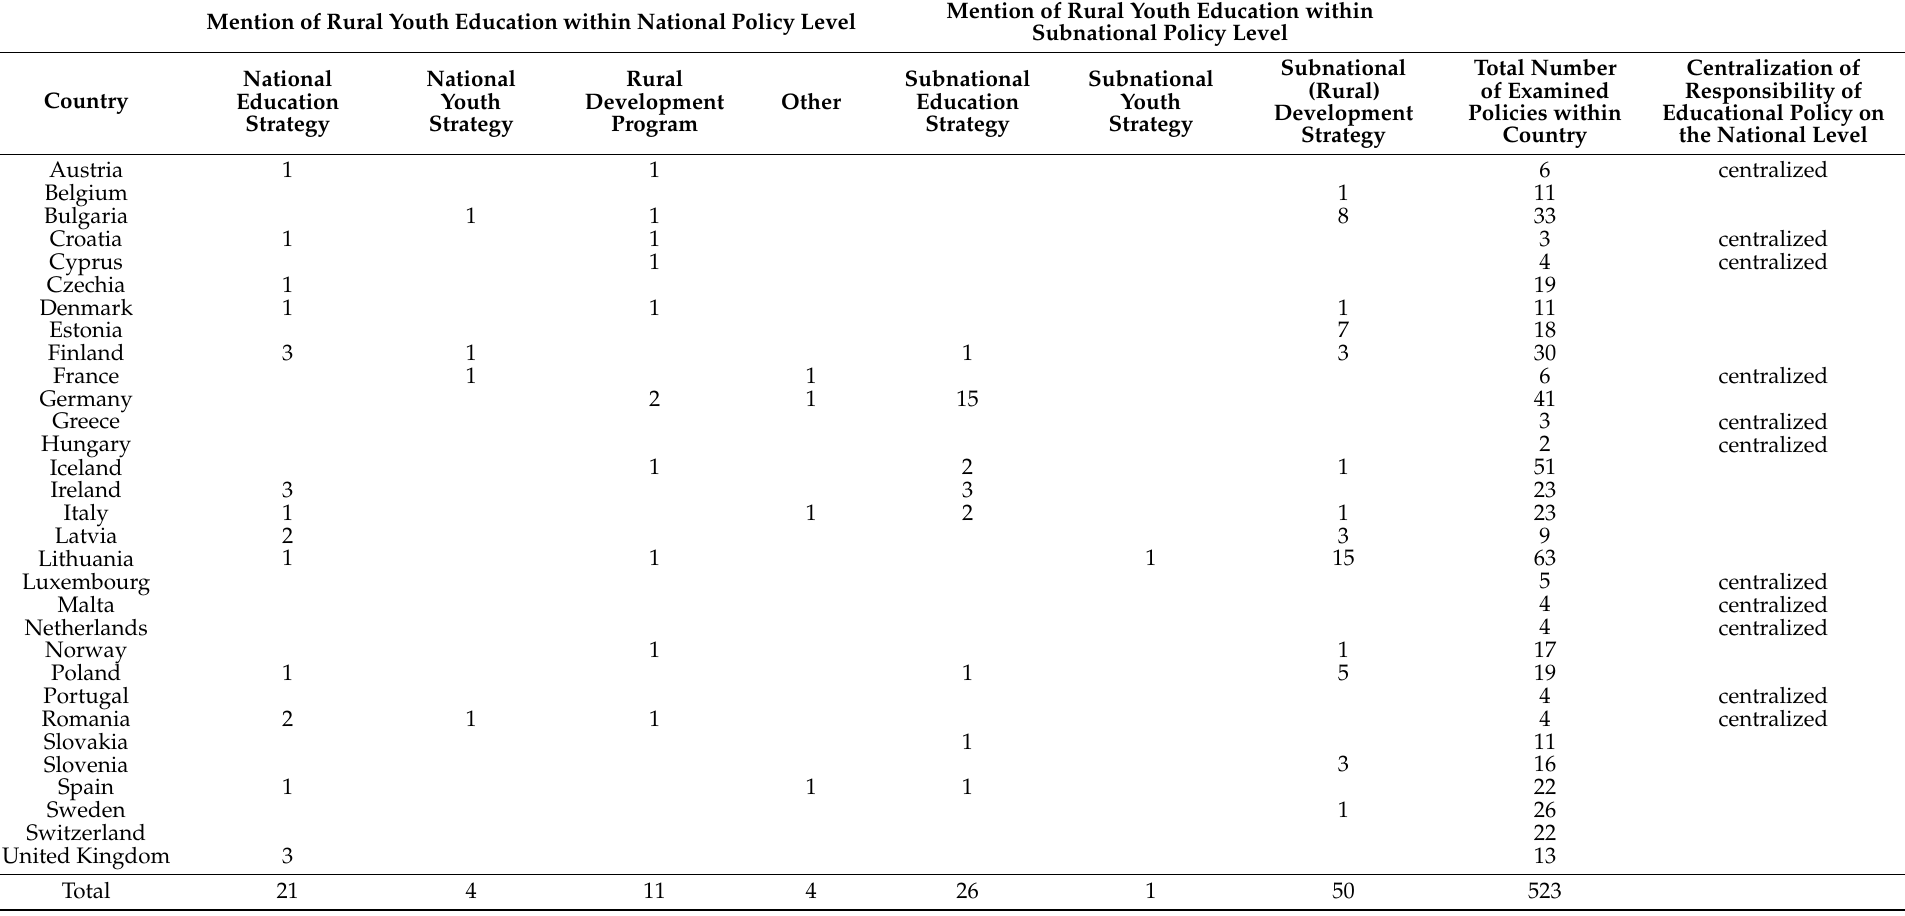
Table 1. Overview of educational policies